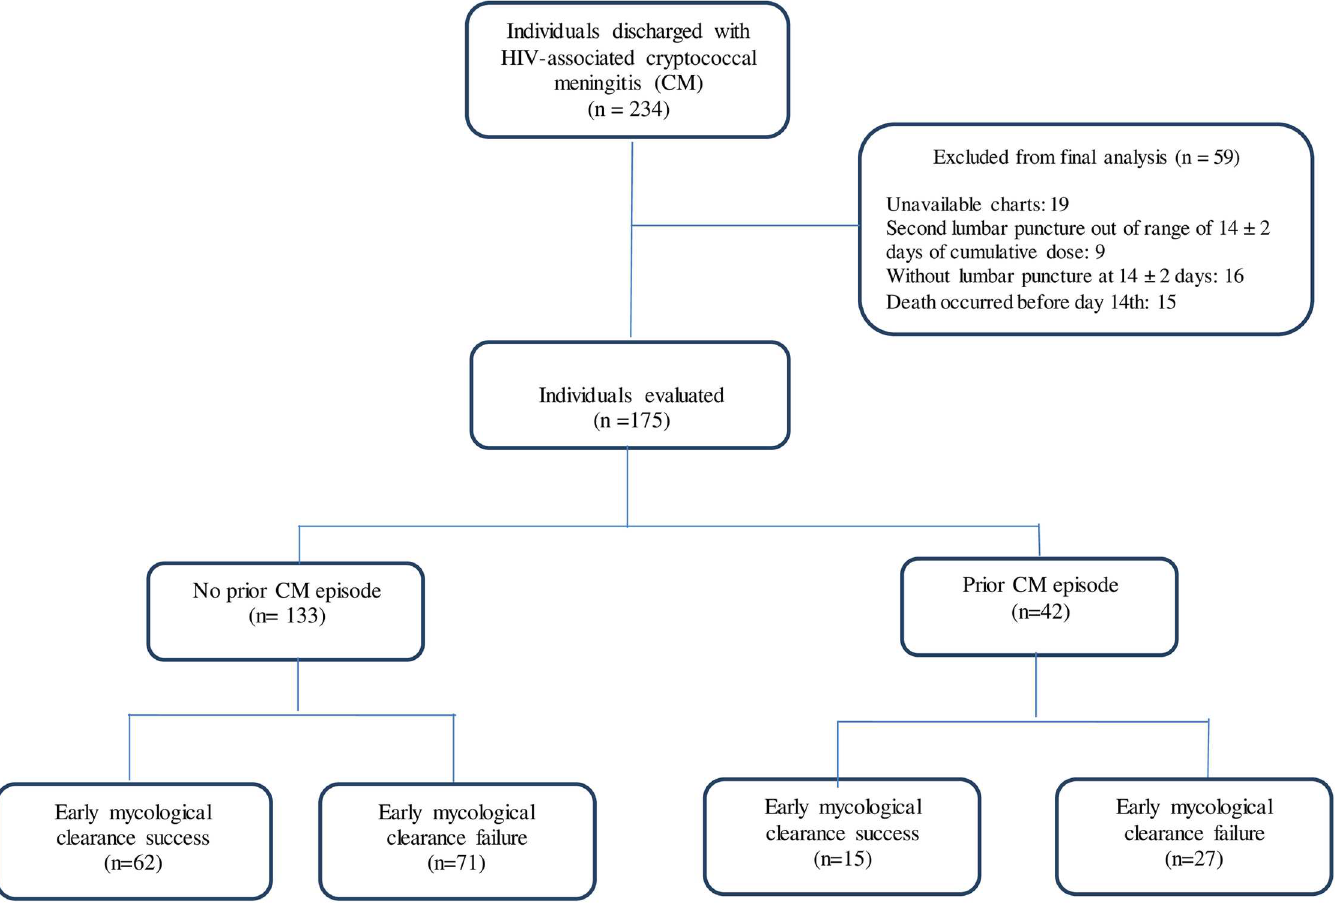
Fig 1. Flowchart of selection of study population among cases discharged with diagnosis of HIV-associated cryptococcal meningitis (2000– 2013).